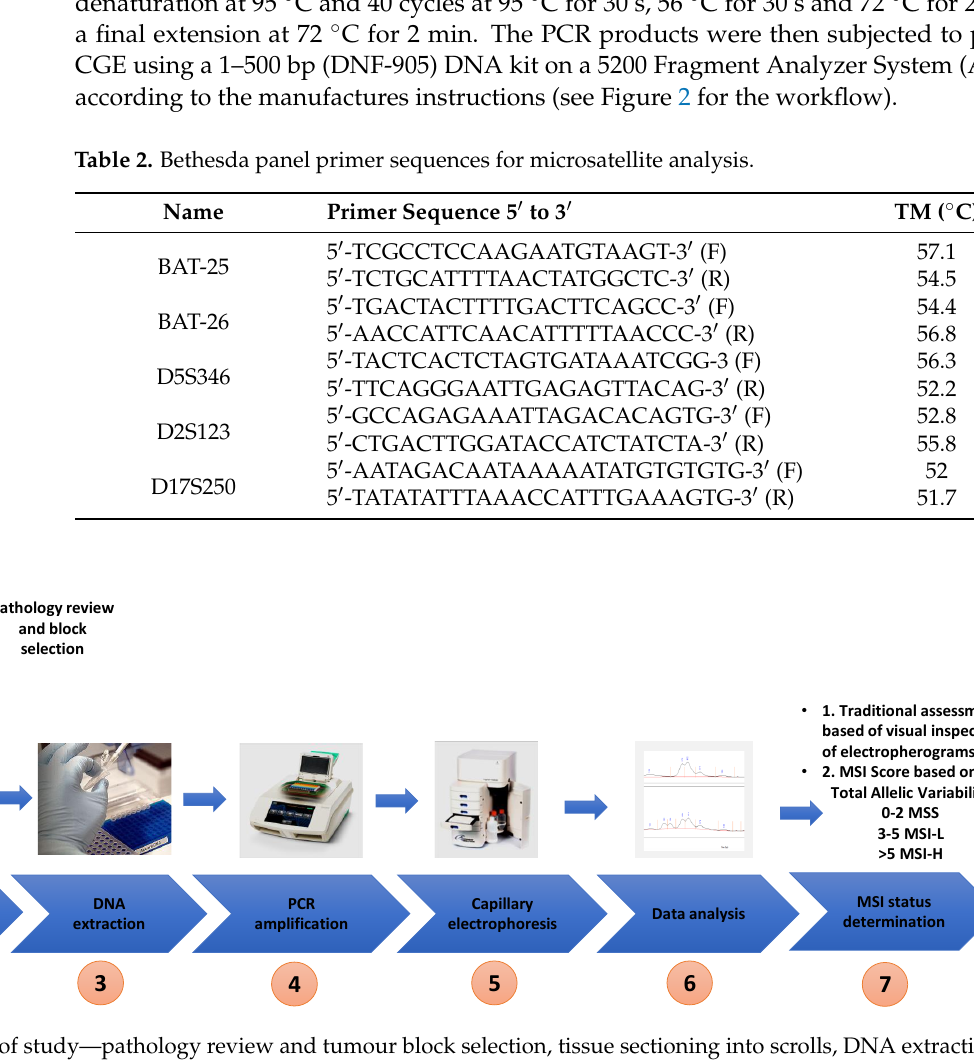
Figure 2. Workflow of study – pathology review and tumour block selection, tissue sectioning into scrolls, DNA extraction, polymerase chain reaction, capillary electrophoresis, inspection of electropherogram / data analysis and determination of MSI status based on allelic variability and MSI score